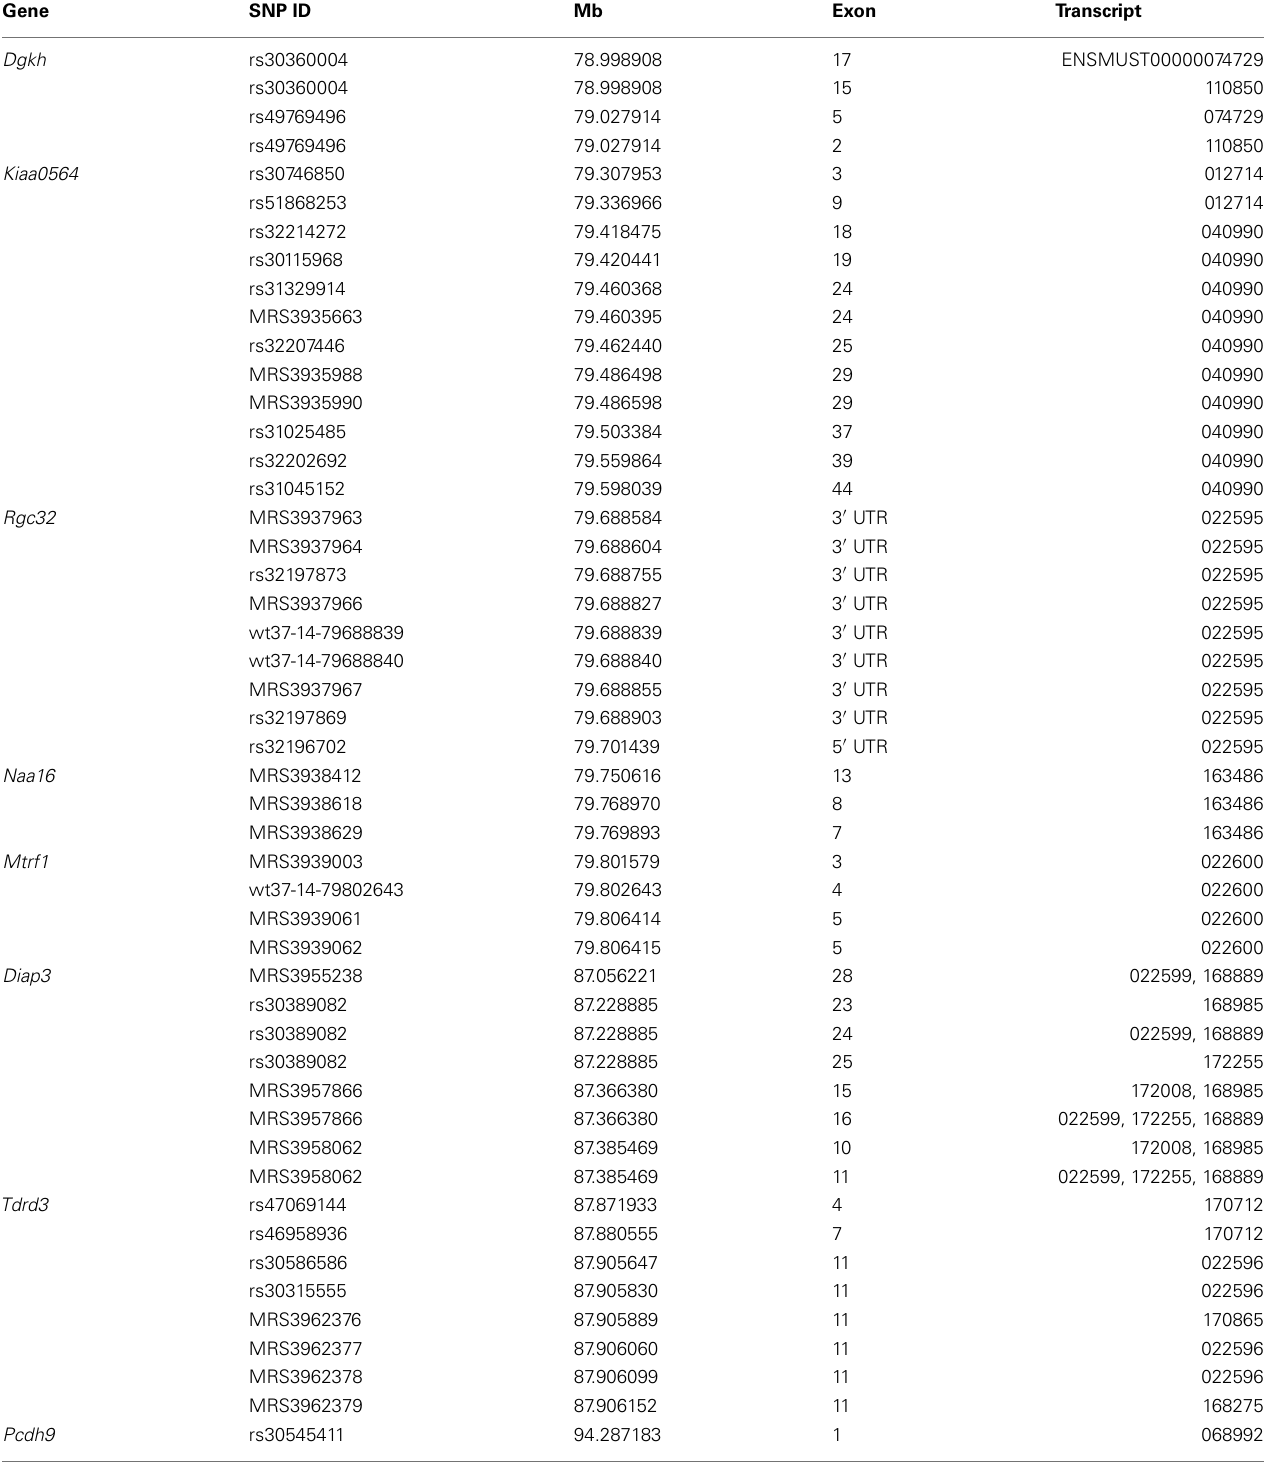
Table 1 | Positional candidate genes on Chr